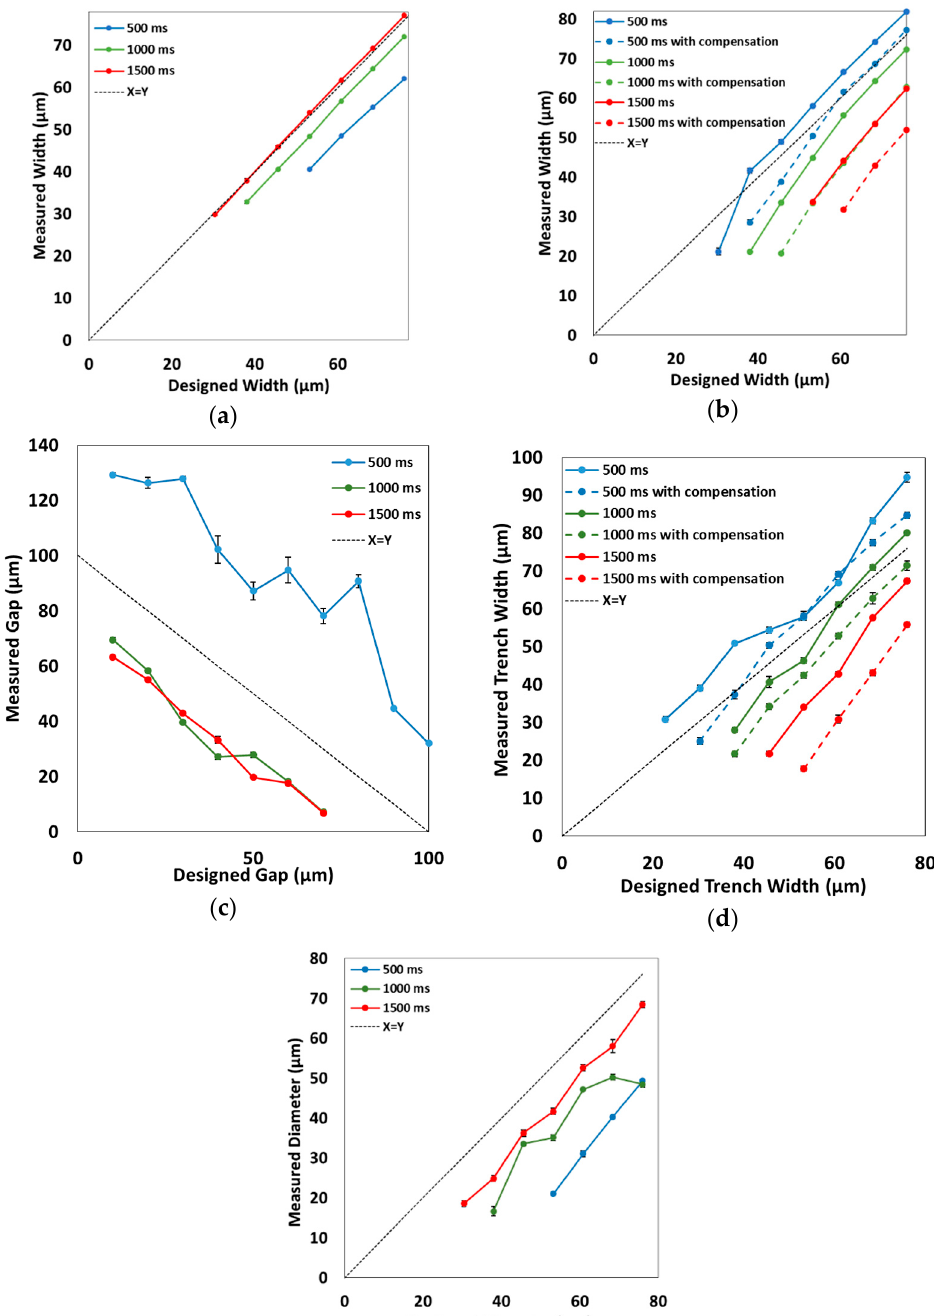
Figure 3. Designed feature width versus measured width for different exposure conditions. Only features that reached >90 μ m in height (ridges) or depth (trenches) were included. For the pillars, only those that were attached floor to ceiling were included. Standard deviations are indicated for each included point ( n = 3). ( a ) Exterior ridges; ( b ) Exterior trenches; ( c ) Interior ridges; ( d ) Interior trenches; ( e ) Interior pillars.